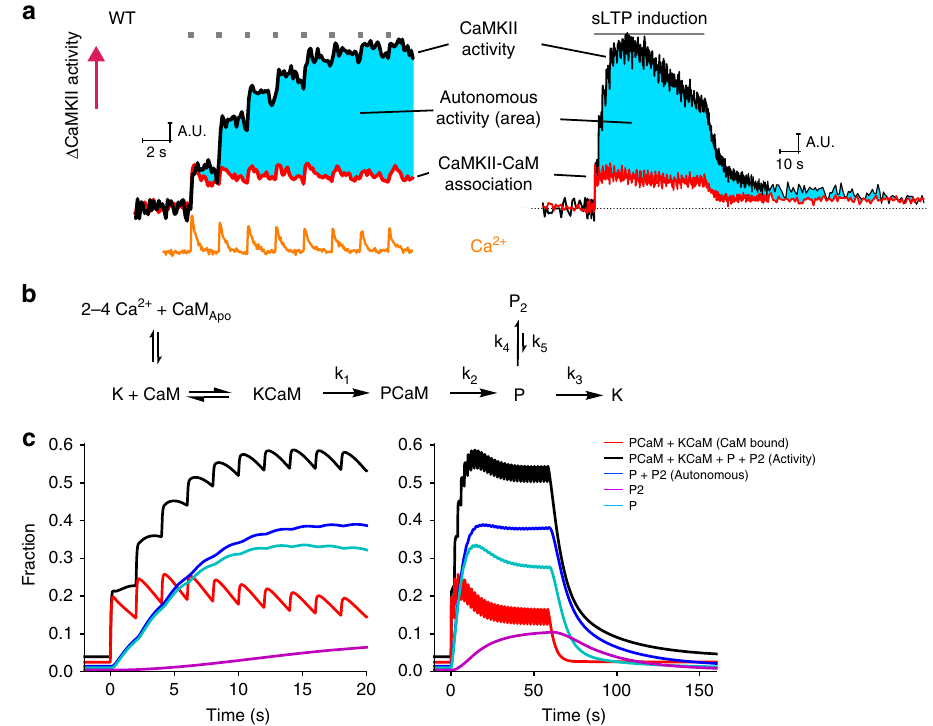
Fig. 6 Simulated CaMKII α activation during spine plasticity induction. a The comparison of CaMKII α activity measured with Green-Camui α (data from ref. 10 ), Ca 2 + measured with Fluo-4FF (data from ref. 10 ), and CaMKII α -CaM association measured in this study. Autonomous activity is the subtraction of CaMKII α -CaM association from CaMKII α activation (cyan). The fi rst time point right after uncaging is matched for CaMKII α -CaM and CaMKII α activity, assuming that there is no autonomous CaMKII α at the time point. b Reaction scheme of CaMKII α activation. K is the inactive state of CaMKII α (closed form), CaM Apo is the inactive form of calmodulin without bound Ca 2 + , CaM is the active form of calmodulin with 2 – 4 bound Ca 2 + ions, P and P 2 are the two different states of Thr286-phosphorylated CaMKII α . c Simulated CaMKII α activation based on the proposed reaction scheme. Black: concentration of total active CaMKII α (KCaM + PCaM + P + P 2 ). Red: concentration of KCaM and PCaM. Green: concentration of Thr286-phosphorylated CaMKII α (P + P 2 ). Light blue: concentration of P state of CaMKII α . Navy: concentration of P 2 state of CaMKII